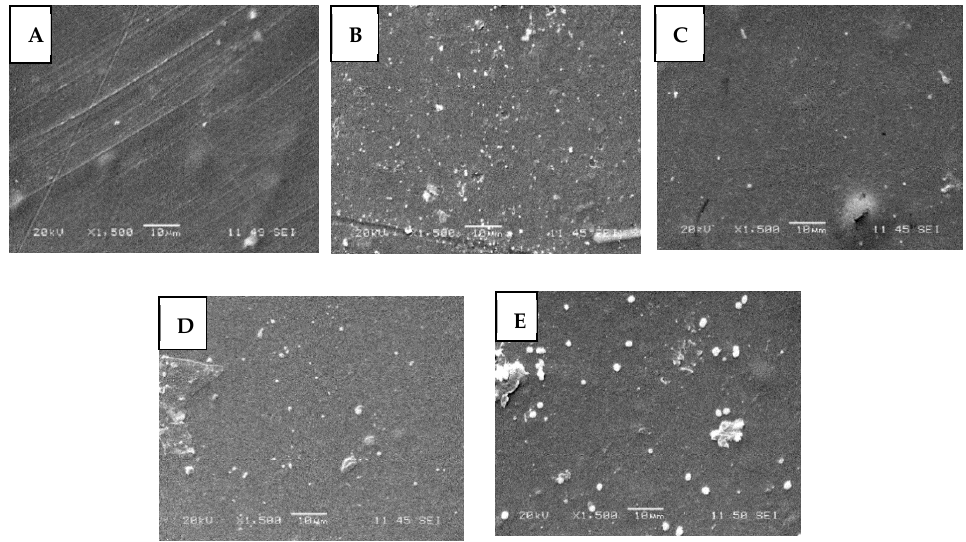
Figure 5. SEM surface morphology of ( A ) pristine CHT films, ( B ) CHT crosslinked GA, ( C ) CHT with Zn–O, ( D ) CHT with Cu, and ( E ) CHT with Zn–O and Cu. with Zn-O, ( D ) CHT with Cu, and ( E ) CHT with Zn-O and